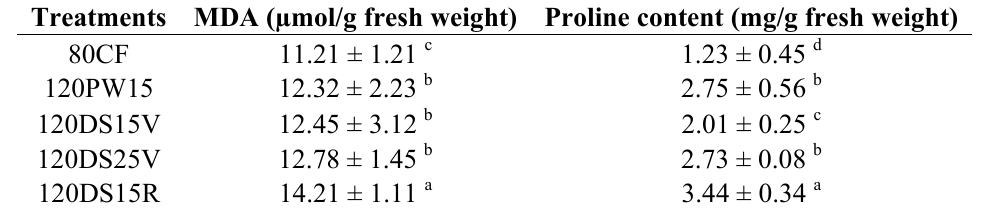
Table 5. Impact of potassium fertilizationon lipid peroxidation and proline content under water stress at different growth stages of rice. Data are means ± standard error of differences between means (SEM). N = 12. Means not sharing a common single letter were significantly different at p ≤